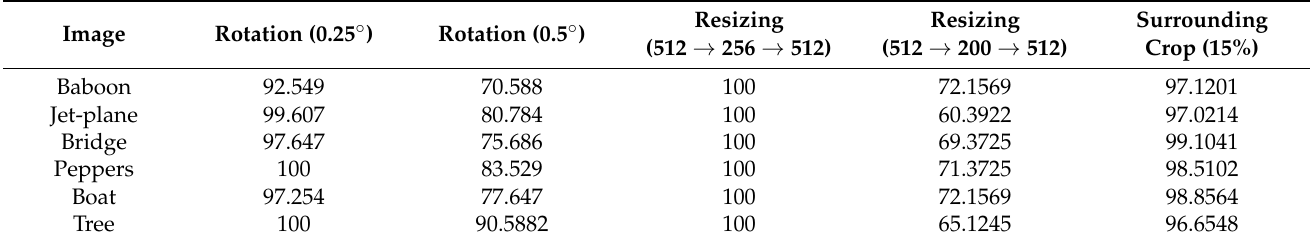
Table 7. Robustness against geometric attacks in terms of BCR (%).